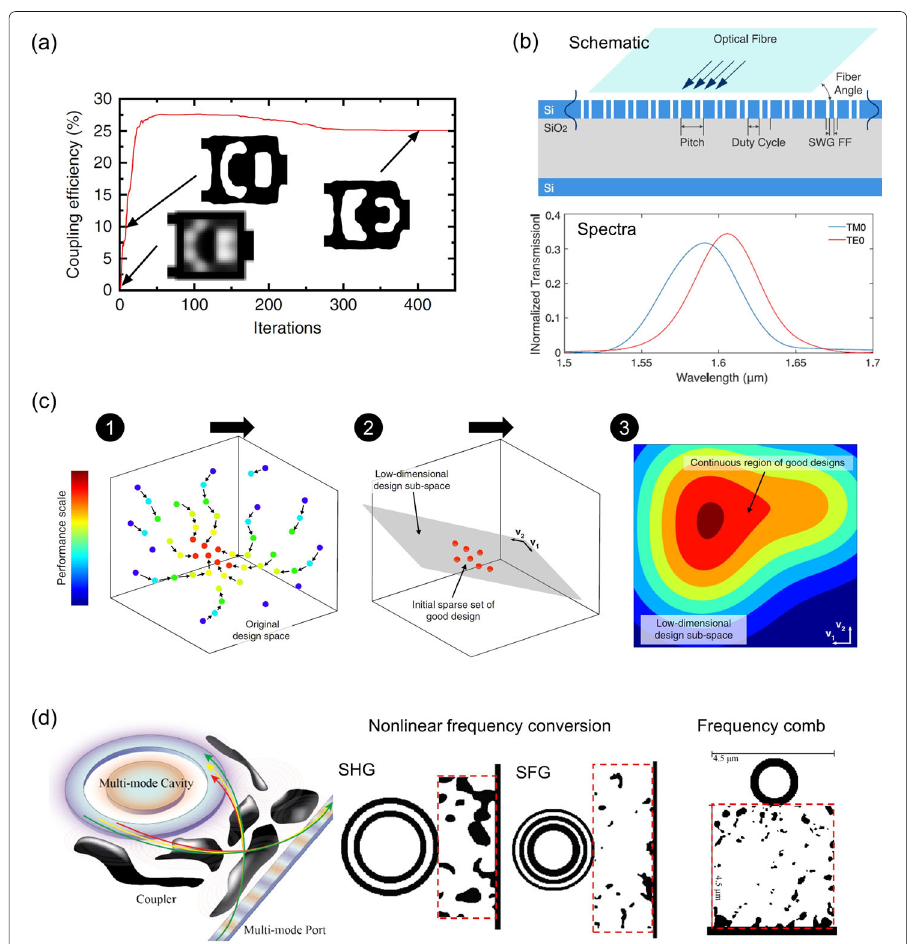
Fig. 8 (a) An inverse-designed diamond vertical coupler with a plot of coupling efficiency. The insets indicate the coupler geographies at three phases. (b) A vertical polarization-insensitive grating coupler developed by an ANN model. Top: the operational configurations. The variables for ANN model are pictured as fiber angle, polarization, grating pitch, the duty cycle, and the fill factor (FF), respectively. Bottom: transmissions of an ANN-created grating coupler. The blue (TM 0 ) and red (TE 0 ) lines cross at 1.596 μ m, resulting in the same amplitude of 0.31, thereby identifying the working wavelength for the requested polarization-insensitive coupler. (c) A ML methodology outlined for vertical grating couplers. The basic procedures contain steps of initial sparse collection of good designs, dimensionality reduction of machine learning and exhaustive mapping of the sub-space stages. (d) Cavity couplers reformed by TO for on-chip nonlinear optical devices. Left: an overall model illustrating functioning principle. The well-arranged black region acts as a coupler for energy exchange between a multimode cavity and a waveguide. Right: three developed couplers (featuring in red-dashed boxes) for second harmonic generation (SHG), sum-frequency generation (SFG), and frequency combs, respectively. In each framed area, black region is made of GaP, while the white part is assumed to be vacuum. Figures reproduced with permission: (a) Ref. [98], Copyright 2019 Nature Publishing Group; (b) Ref. [99], Copyright 2018 IEEE; (c) Ref. [100], Copyright 2019 Nature Publishing Group; (d) Ref. [101], Copyright 2018